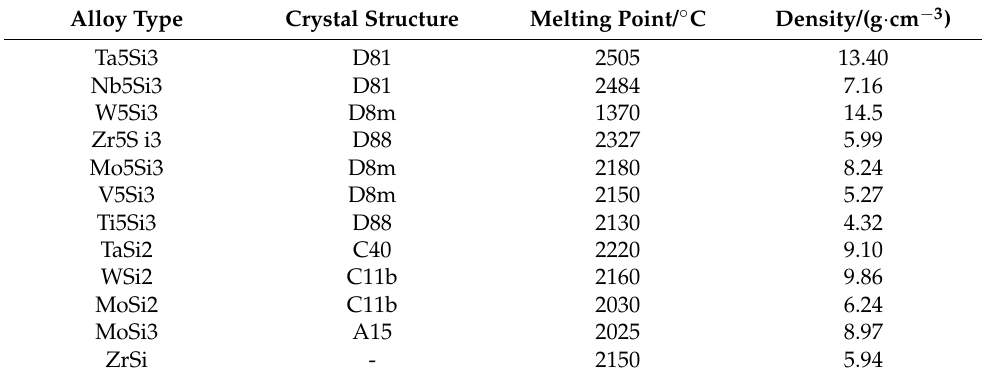
Table 2. Structure and properties of some silicides with melting points over 2000 ◦